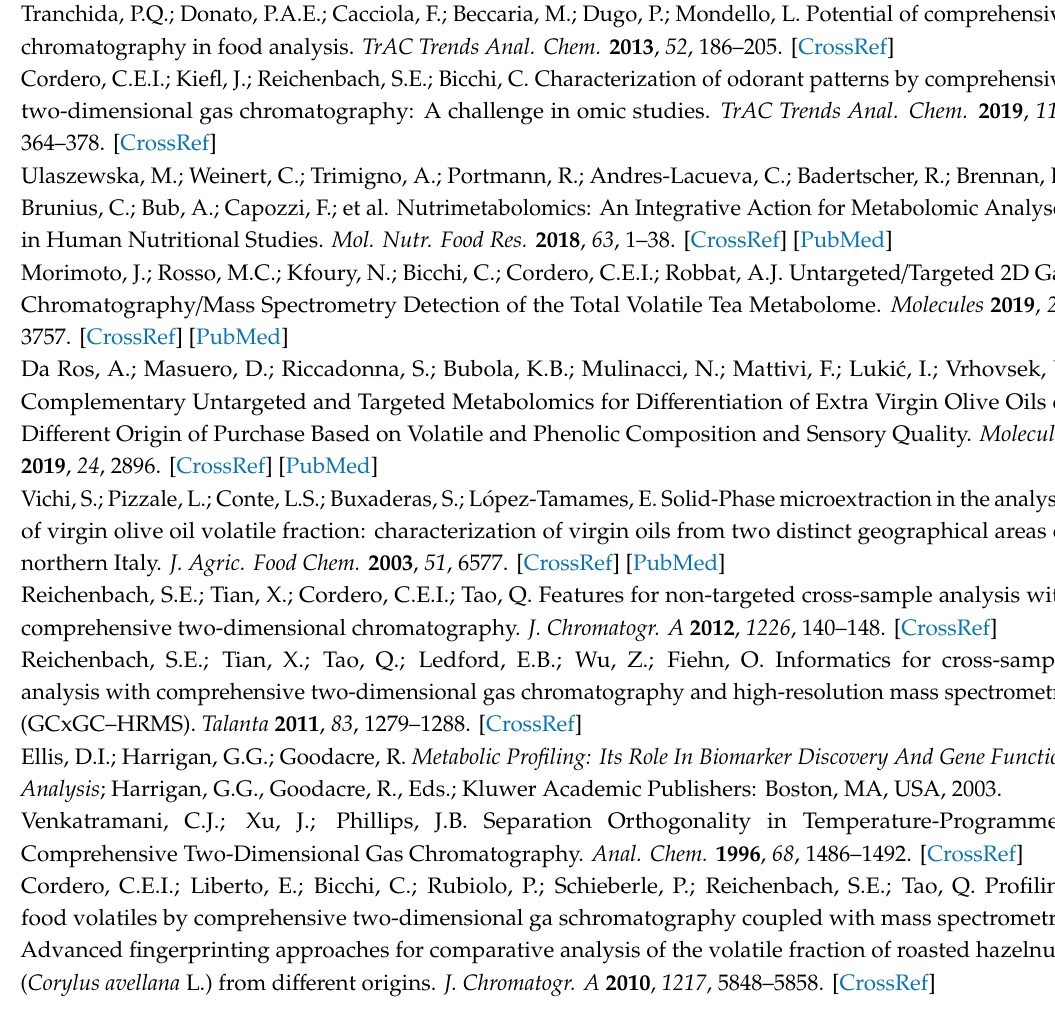
Supplementary Materials: The following are available online: Figure S1: 2D data elaboration work-flow adopted to comprehensively map tea primary metabolites signatures, by adopting a combined untargeted and targeted UT template matching approach. Figure S2: schematic diagram of the extraction and derivatization procedure. Figure S3: experimental results on targeted primary metabolites extraction yields. Figure S4: method repeatability is indicated in terms of % relative standard deviation (%RSD) for both chromatographic dimensions ( 1 t R and 2 t R ) and for % response, collected from UT